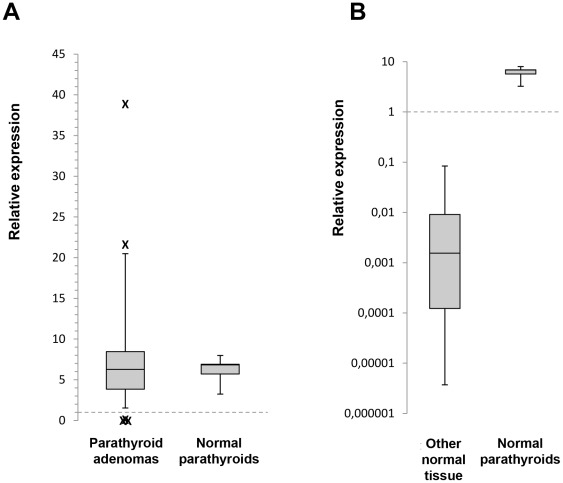
qRT-PCR analysis for PRLR expression in normal parathyroid tissue and parathyroid tumours.Box-plots showPRLR-total mRNA expression after normalization in normal parathyroid tissue and parathyroid tumours (A), and normal parathyroid and other normal tissues (B). The arbitrary value of 1.0 indicating the expression level in MCF-7 cells is indicated.